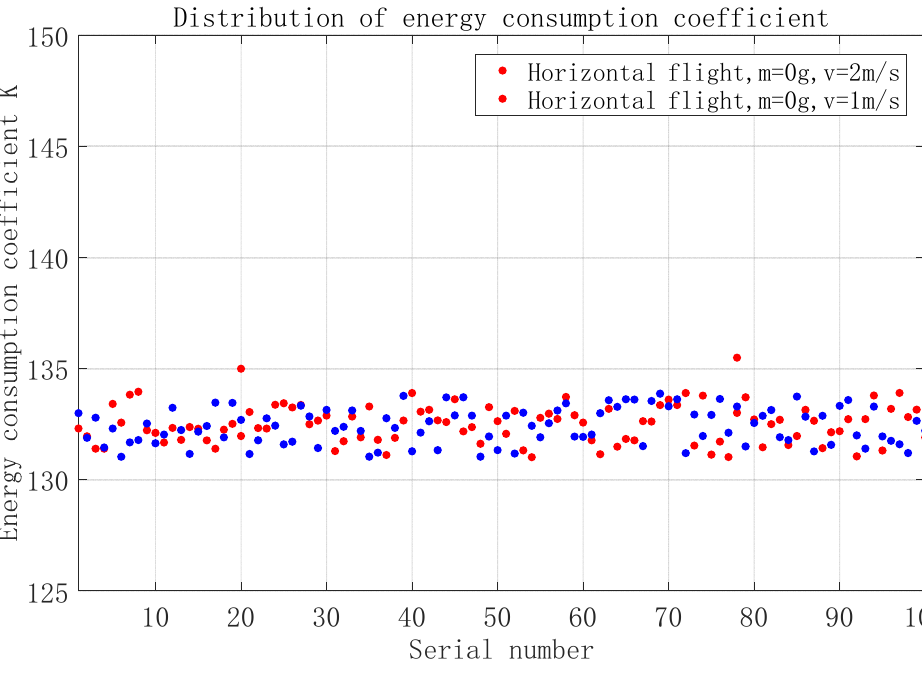
Figure 2. Distribution of energy consumption coefficient at different flight speeds.